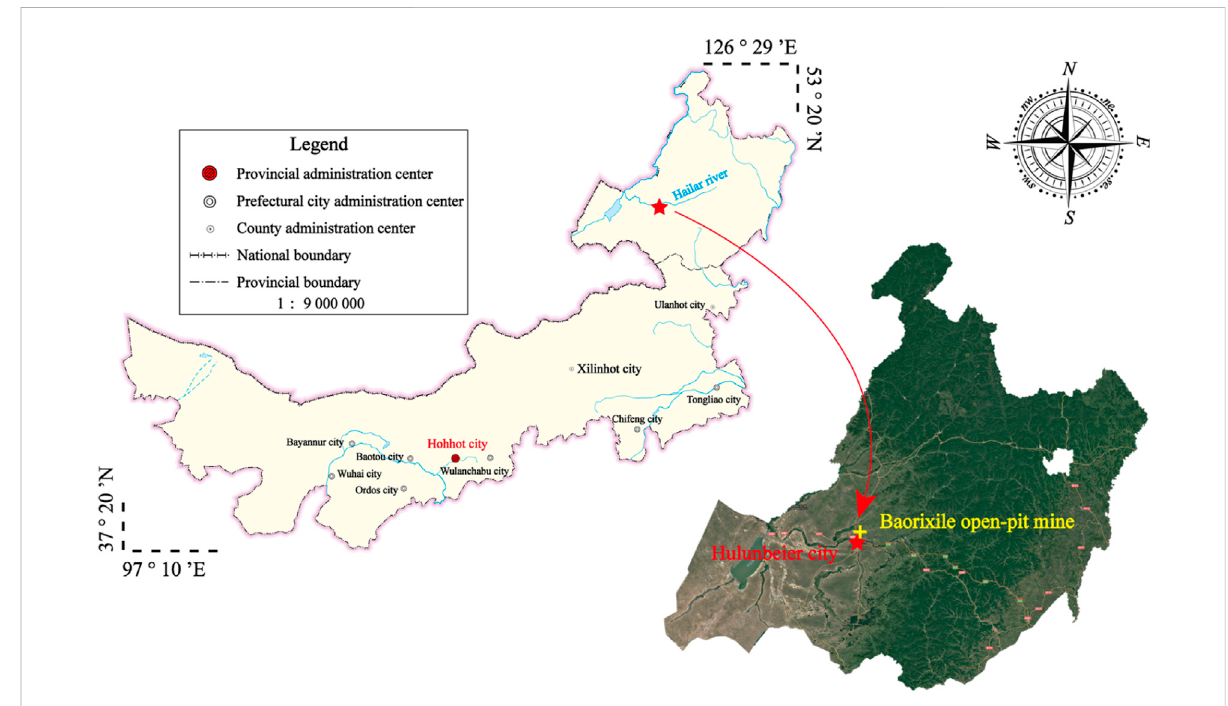
FIGURE 5 The location of the Baorixile open-pit mine.